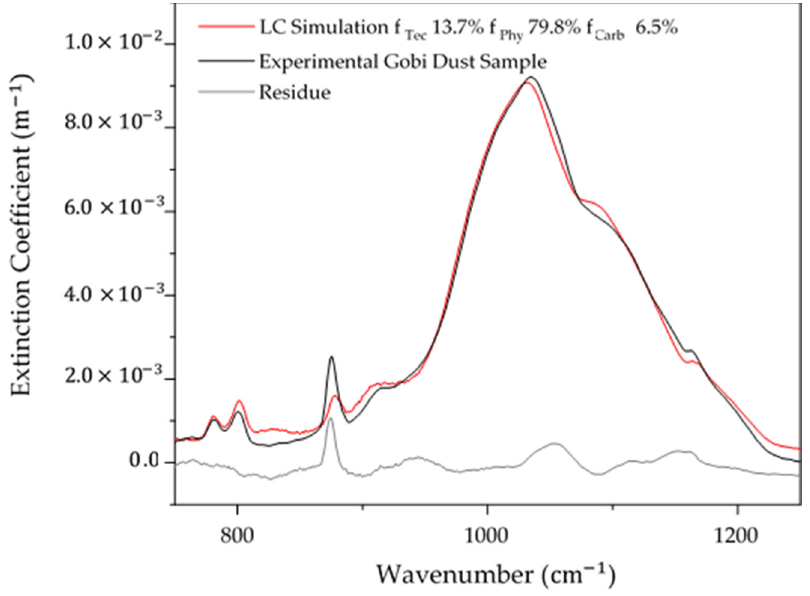
Figure 11. Simulation of the linear combination of pure mineral coefficients (red) fitted with the experimental Gobi dust extinction spectrum (black) with the remaining residue from the simulation and experimental spectrum (gray) and the RMS (light gray envelope).